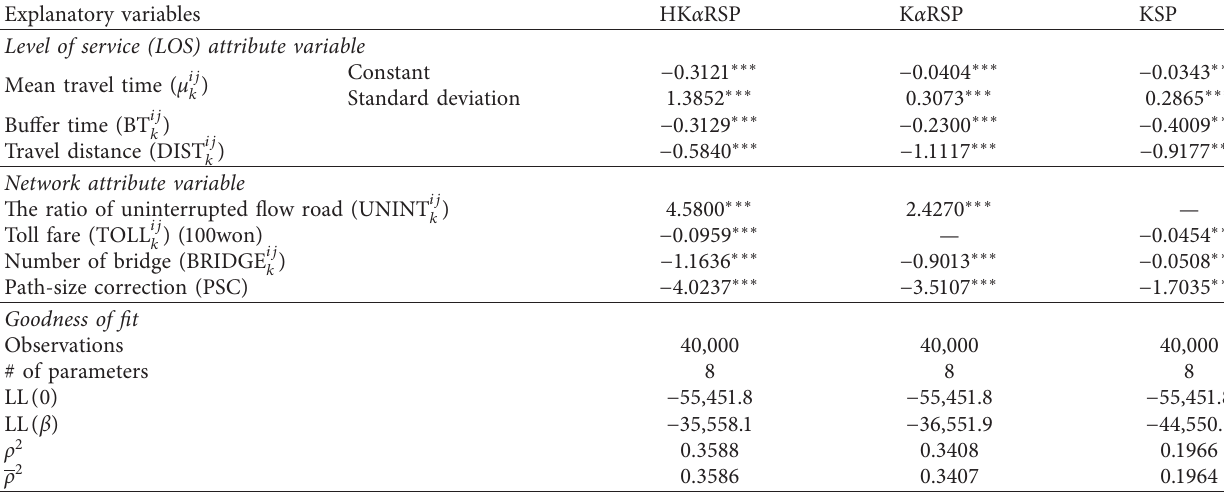
Table 3: Result of MPSCL model with truncated normal